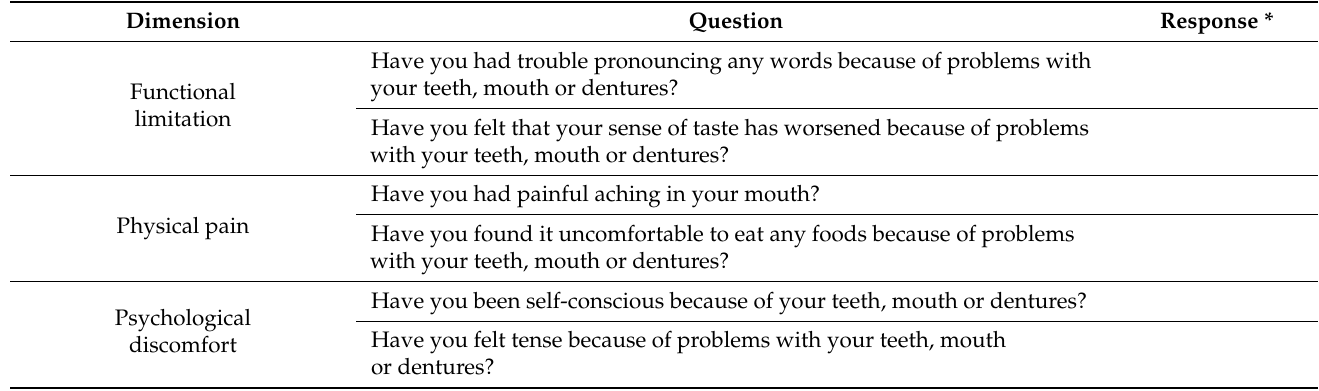
Table A1. OHIP-14 Questionnaire. * O = never, l = hardly ever. 2 = occasionally 3 = fairly often, 4 = very often.